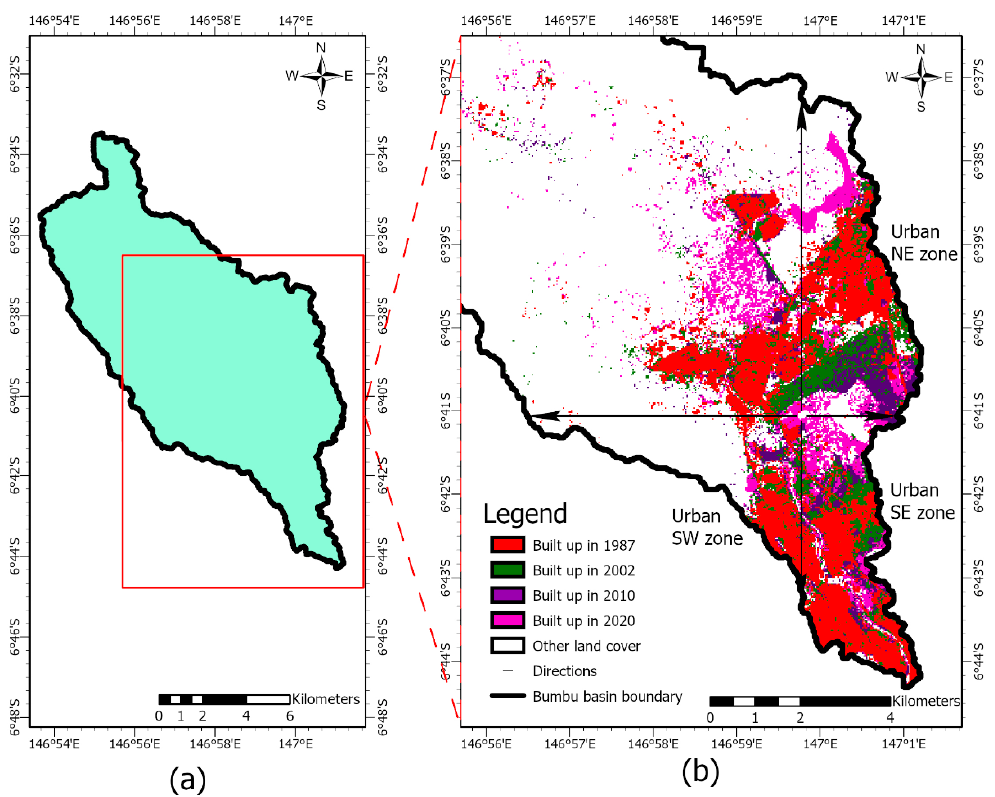
Figure 5. ( a ) Bumbu river basin, ( b ) The spatial change of the urban extent of Bumbu basin in the years 1987, 2002, 2010, and 2020.